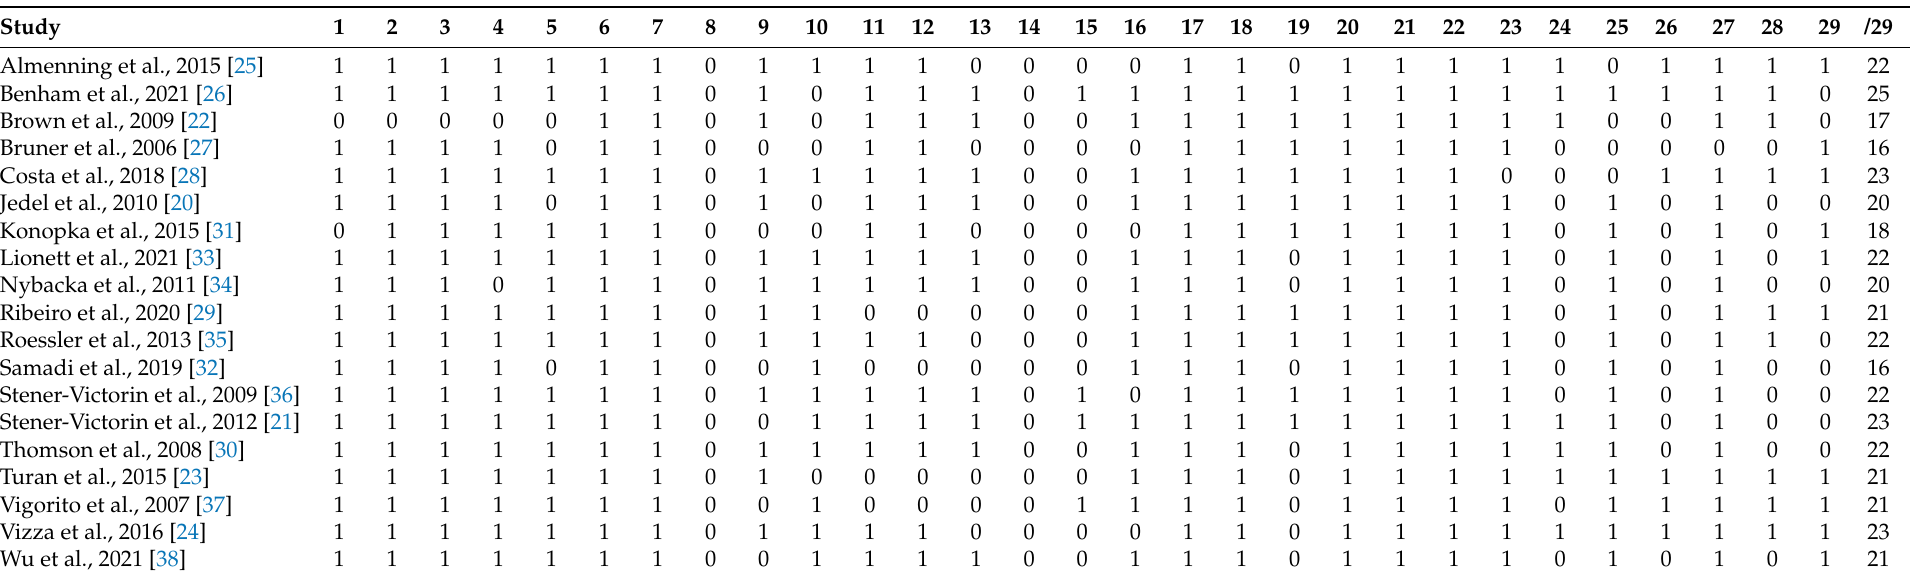
Table 3. Results of modified Downs and Black for methodological quality